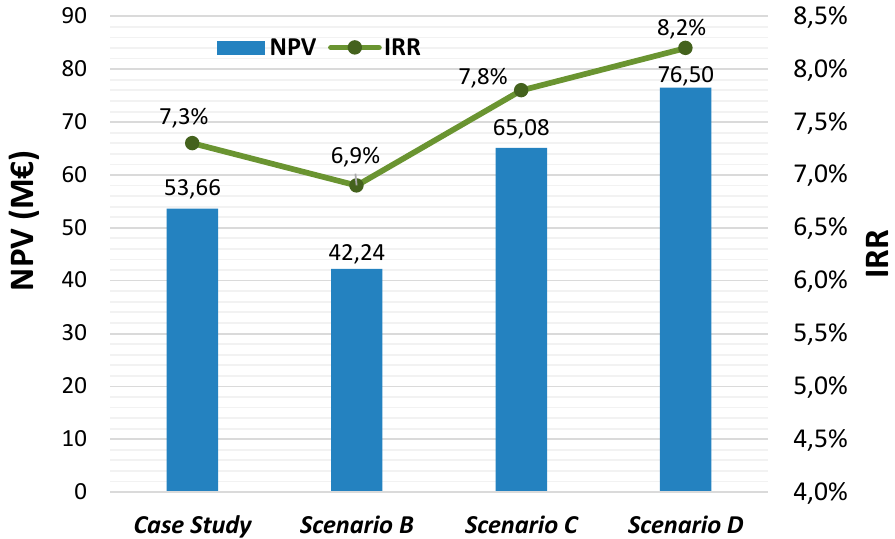
Figure 6. Sensibility analysis of the NPV and IRR parameters depending on the energy sales